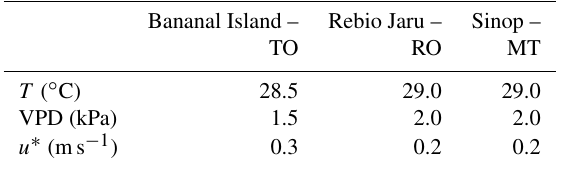
Table 2. Fixed values of temperature ( T ), vapor pressure deficit (VPD), and friction velocity ( u ∗ ) for three sites evaluated in the first test. Bananal Island – Rebio Jaru – Sinop – TO RO MT T ( ◦ C) 28.5 29.0 29.0 VPD (kPa) 1.5 2.0 2.0 u ∗ (ms − 1 ) 0.3 0.2